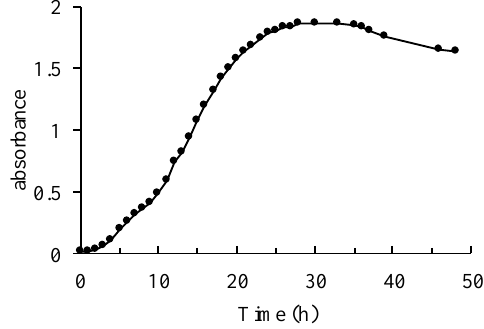
Figure 2. Growth curve of strain CW126-A03.